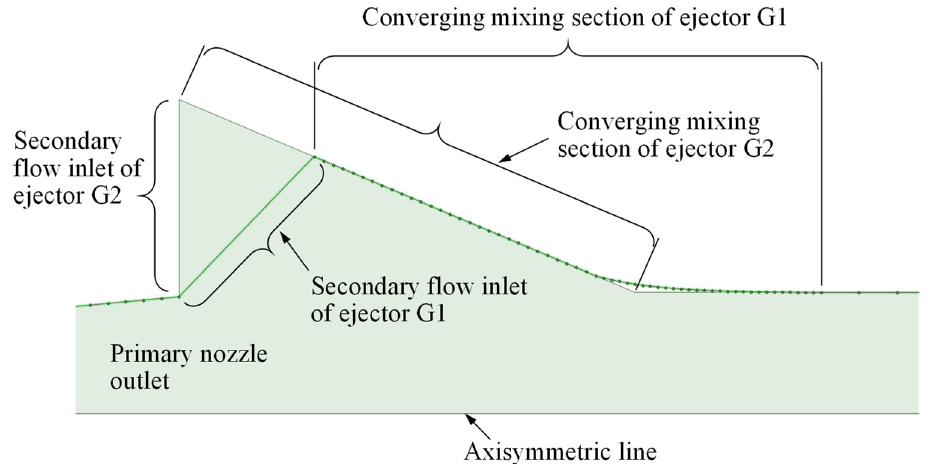
Figure 4. The zoomed-in ejector geometry around the converging mixing section. The base geometry for the parametric study, ejector G2, (solid grey lines) is superimposed on the geometry for the CFD validation, ejector G1, (the solid green lines connecting the green dots).